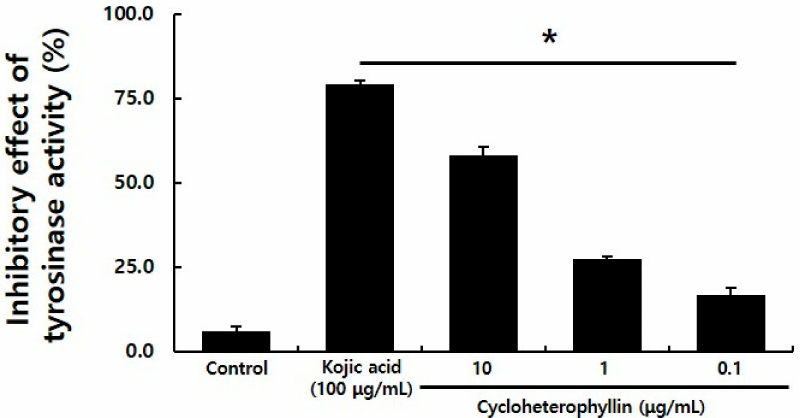
Figure 2. Tyrosinase activity inhibition effect of cycloheterophyllin. Results are the average of triplicate samples. * p < 0.05 compared with the